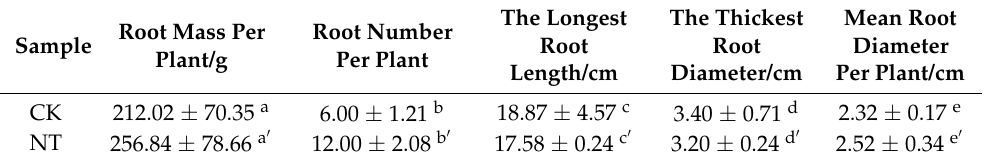
Table 1. The comparison between the morphological indices of NT and CG.